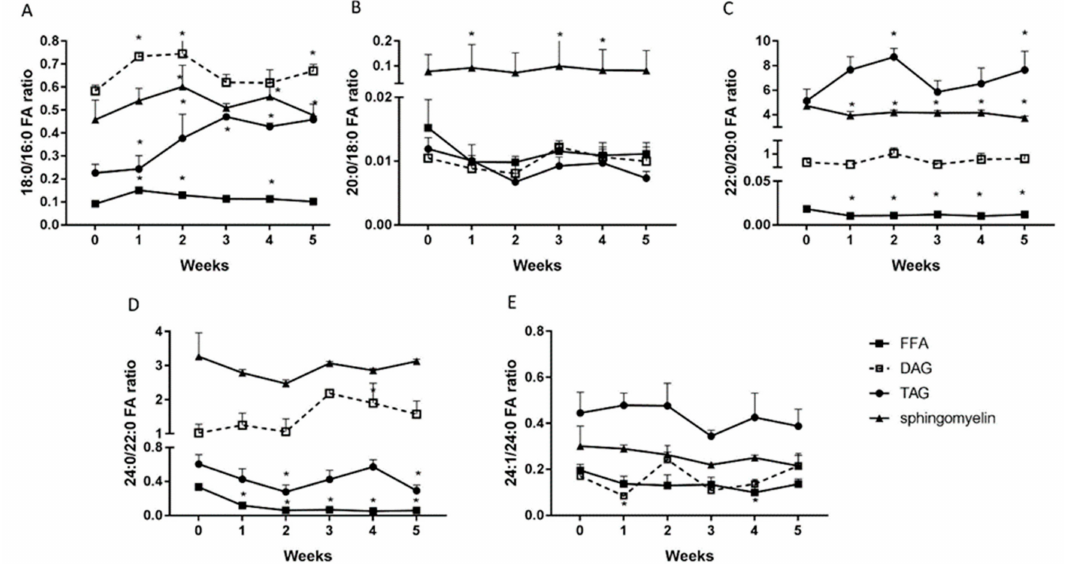
Figure 6. Elongation ratio of the stearic acid / palmitate (18:0 / 16:0) ( A ), arachidic acid / stearic acid (20:0 / 18:0) ( B ), behenic acid / arachidic acid (22:0 / 20:0) ( C ), lignoceric acid / behenic acid (24:0 / 22:0) ( D ) and the ratio of unsaturated to saturated fatty acids (desaturation index), i.e., nervonic acid / lignoceric acid (24:1 / 24:0) ( E) in triacylglycerols, diacylglycerols, free fatty acids, and sphingomyelin in liver homogenates from control group (0 week) and HFD group at the end of each experimental week (1, 2, 3, 4 and 5). Elongation and desaturation ratios were calculated based on fatty acid composition measured by GLC method. The data are expressed as the mean ± S.D. and are based on six independent determinations ( n = 6). * p < 0.05 significant di ff erence vs control group (0 week).